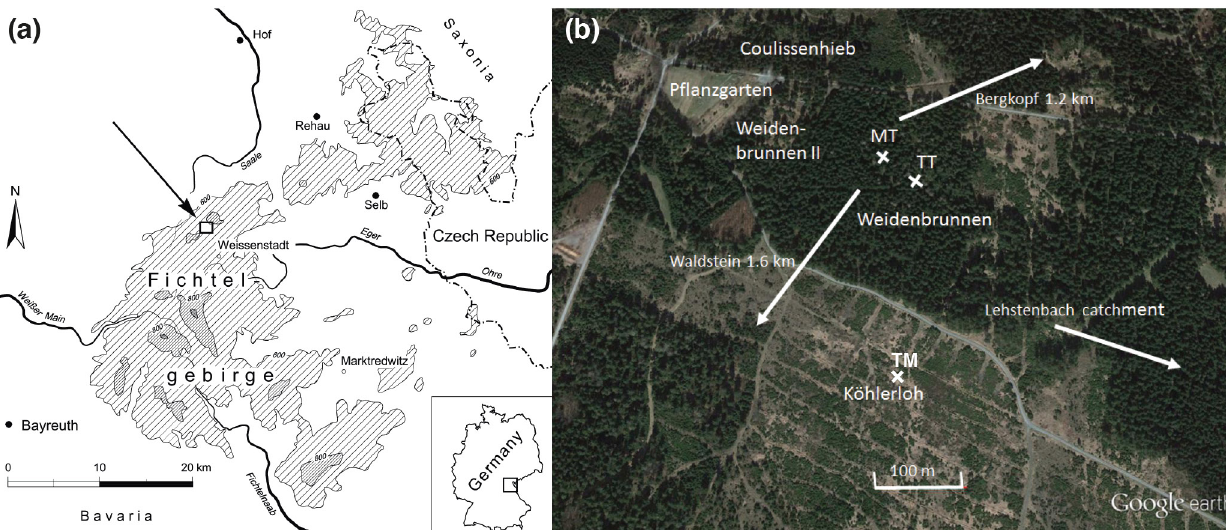
Figure 1. (a) Location of the BayCEER research site at the Waldstein hillsides in the Fichtelgebirge (modified from Gerstberger et al., 2004), published with the kind permission of Springer, Berlin, Heidelberg, 2004. (b) Aerial picture of the patchy landscape showing meteorological towers and masts as well as the measuring points that are important for this study. MT: main tower, TT: turbulence tower, TM: turbulence mast; modified from Foken et al. (2017a) and published with the kind permission of Springer, Berlin, Heidelberg, 2017, and Google Earth, 2015. Table 1. Vegetation at the forest and the Köhlerloh clearing with their main characteristics according to Foken et al. (2017a). Species Ground Height PAI MSC a Forest Spruce ( Picea abies ) 100 Clearing Crinkled hair grass ( Deschampsia flexuosa ) Young spruce ( Picea abies ) Blueberry ( Vaccinium myrtillus ) Reed, bent, and true grasses ( Calamagrostis, Agrostis, Poaceae ) Rush and sedge family ( Juncaceae, Cyperaceae ) Other herbaceous b Moss Dead grass, bare soil Deadwood Small